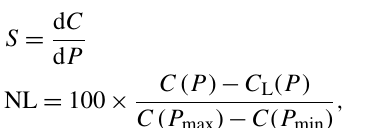
Figure 7. Experimental setting. (1) LCZ meter, (2) Micro- LabExAO board, (3) syringe pump, (4) differential pressure sensor MPXV7025DP, and (5) fabricated pressure